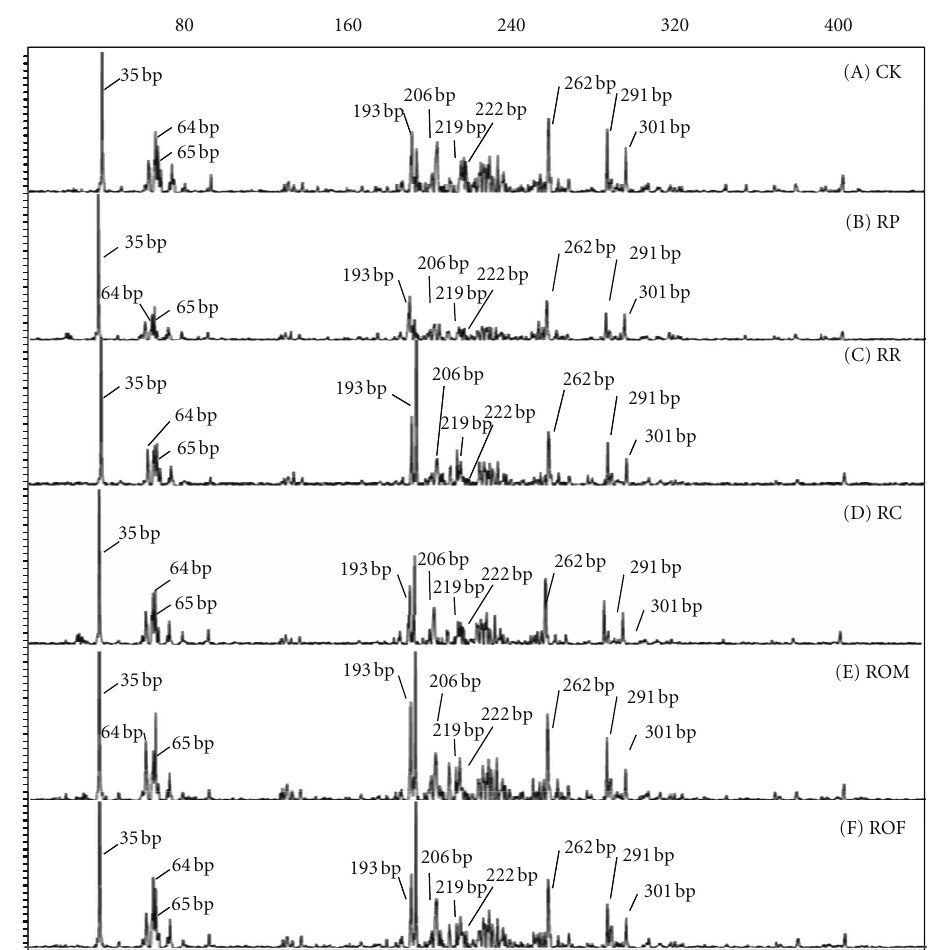
Figure 2: Terminal restriction fragment length polymorphism profiles of soil bacterial communities derived from six di ff erent rotation fields before transplanting (BR): CK (rice-fallow phase), RR (rice-ryegrass), RP (rice-potato, with rice straw as mulch), RC (rice-Chinese milk vetch), ROM (rice-oilseed rape with burned straw return after harvest), and ROF (rice-oilseed rape with fresh straw return as mulch at flowering) are shown. Terminal fragments were generated by a HaeIII digestion of 16S rRNA gene fragments amplified from total community DNA. Selected terminal restriction fragments di ff ering in their relative abundance between the studied sites are